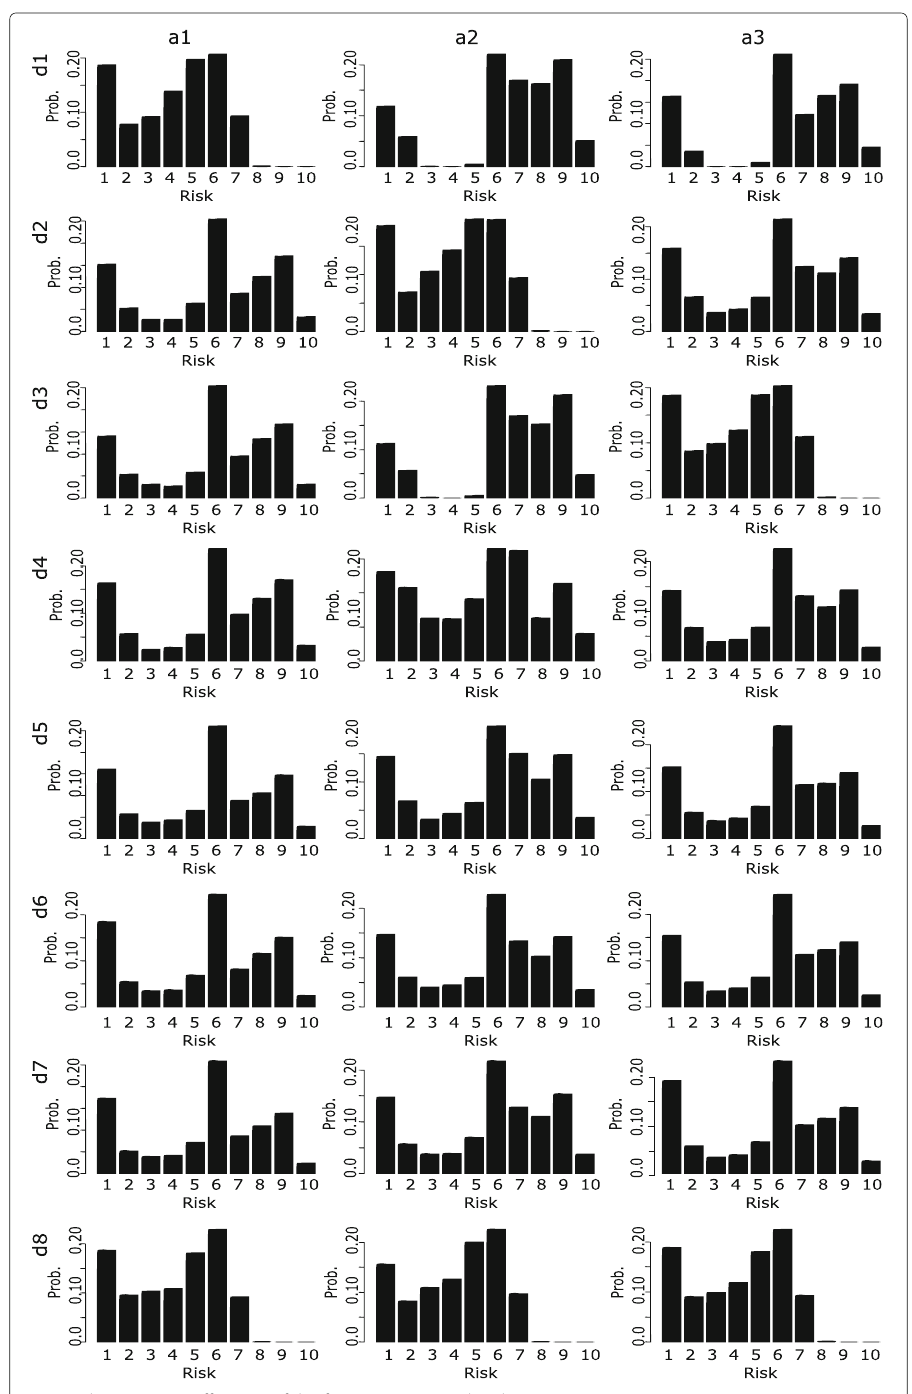
Fig. 4 The 8 × 3 payoff matrix of the first game ( G 1 ) in the chain; M 1